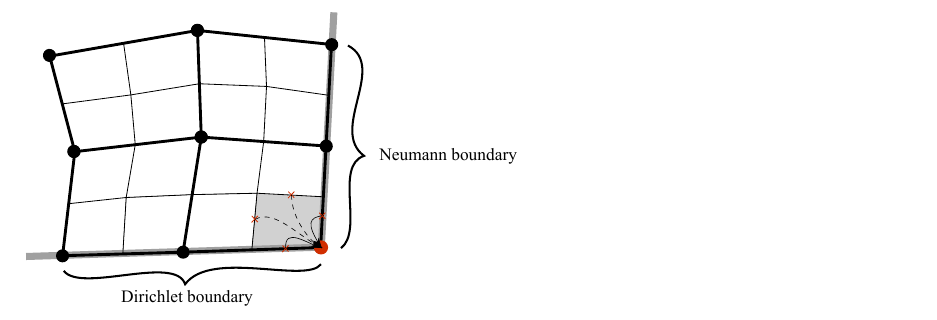
Figure 5. Boundary node shared by two adjacent boundaries, a Dirichlet-type boundary and a Neumann-type one. Flux contributions from boundary integration points and interior integration points are pointed out by arrows from the integration points to the boundary